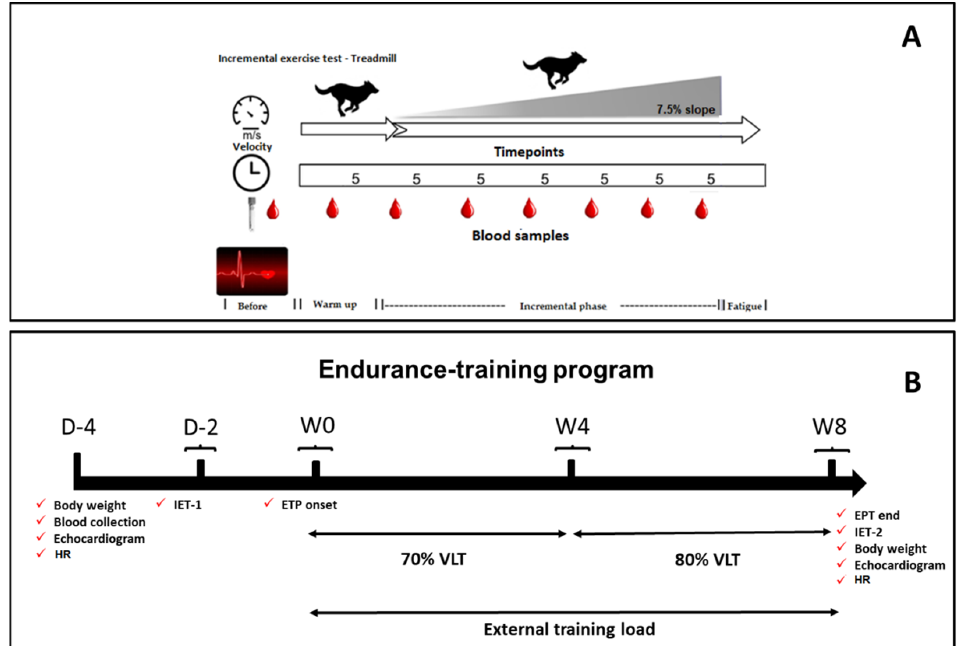
Figure 1. Workflow of the endurance training program (EPT). The beagle dogs were subjected to an incremental exercise test (IET-1) and their lactate threshold (LT) was determined. Treadmill